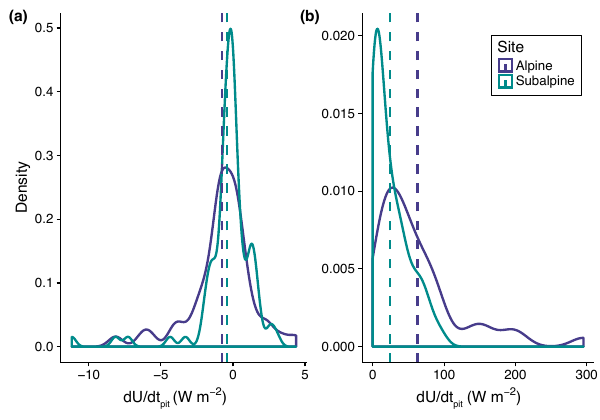
Figure 4. Kernel density estimates of d U lated from snow pit observations for periods with SWE gain (a) and loss (b) in the alpine and subalpine for WY2007–WY2013. The dashed vertical lines represent the mean d U ( a : − 0.8Wm − 2 ; b : 62.8Wm − 2 ) and subalpine ( a : − 0.4Wm − 2 ; b : 23.9Wm − 2